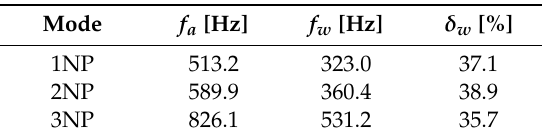
Figure 6. Shapes of the first three modes of vibration of the single blade. Table 4. Natural frequencies in air ( f a ) and water ( f w ), and frequency reduction ratios ( δ w ) of the single blade modes with 1, 2 and 3 nodal points (NP).